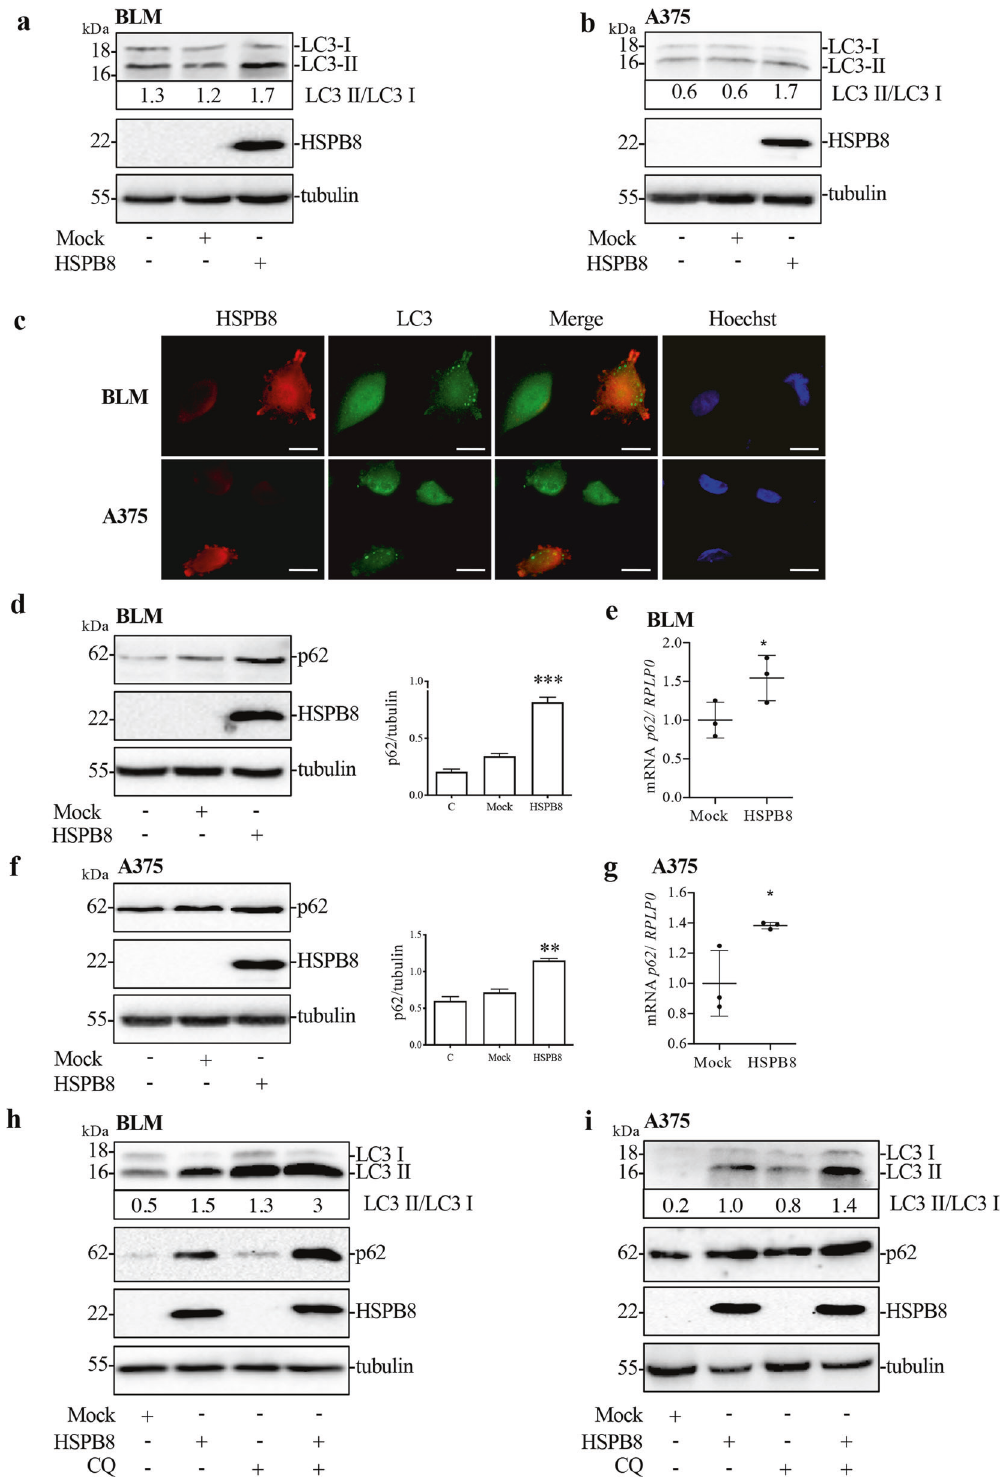
Fig. 6 Effect of HSPB8 overexpression on autophagy in BLM and A375 cells. a , b WB analysis of LC3 in BLM ( a ) and A375 ( b ) overexpressing HSPB8 (48h). c LC3 puncta (green) and HSPB8 expression (red) were carried out by immuno fl uorescence in BLM and A375 cells overexpressing HSPB8 (48h). Nuclei were stained by Hoechst. Scale bar, 20 μ m. d , f Protein expression of p62 in BLM ( d ) and A375 ( f ) cells overexpressing HSPB8 (48h). The quanti fi cation results were calculated over three individual experiments. Bar graph represents the mean optical density±SD. Statistical analysis was performed using One-way ANOVA followed by Bonferroni post-hoc test (** p <0.01 vs. Control (C) and mock; *** p <0.001 vs. Control (C) and mock). e , g p62 mRNA levels in BLM ( e ) and A375 ( g ) cells overexpressing HSPB8 (24h). Data have been normalized to the amount of RPLP0 mRNA. Bar graph represents the mean of three independent biological samples ( N = 3) ±SD. Statistical analysis was performed using Student ’ s t -test (* p <0.05 vs. mock). h , i WB analysis of LC3 and p62 in BLM ( h ) and A375 ( i ) cells overexpressing HSPB8 (48h) treated with CQ 10 μ M for the last 24h of transfection. Cell Death and Disease (2022)